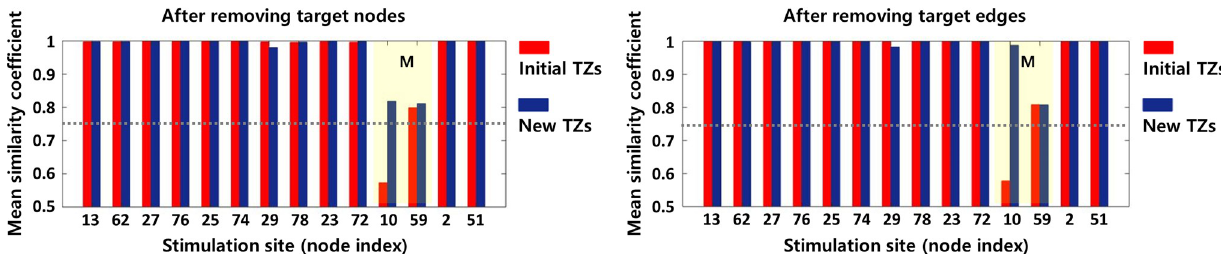
Fig 5. Safety evaluation results for the initial TZs and the new TZs obtained by the feedback. The histogram shows the mean value of the similarity coefficients between the responsive activation patterns due to stimulation in all brain regions, before and after removal of the target nodes and target edges, respectively. While the elimination of initial TZs has a value lower than threshold (0.75) when stimulation is applied to node 10 to reproduce memory network (M), the removal of new TZs has values higher than the threshold in all stimulation sites.